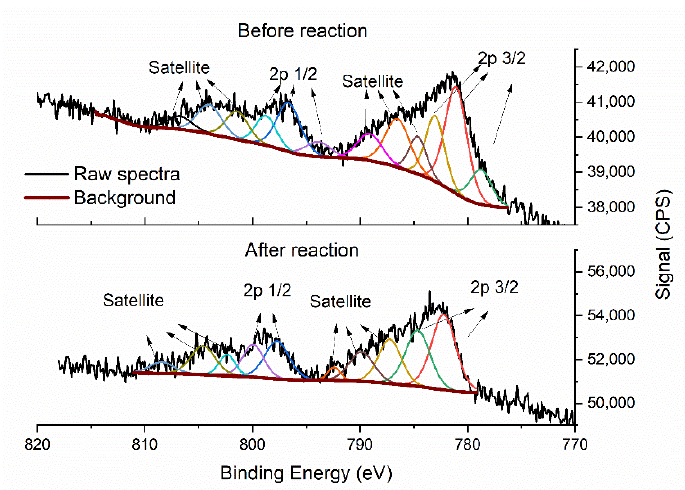
Figure 10. Co 2p X-ray photoelectron spectroscopy (XPS) region of 2 wt.% Co/CNR115 catalyst before and after reaction.